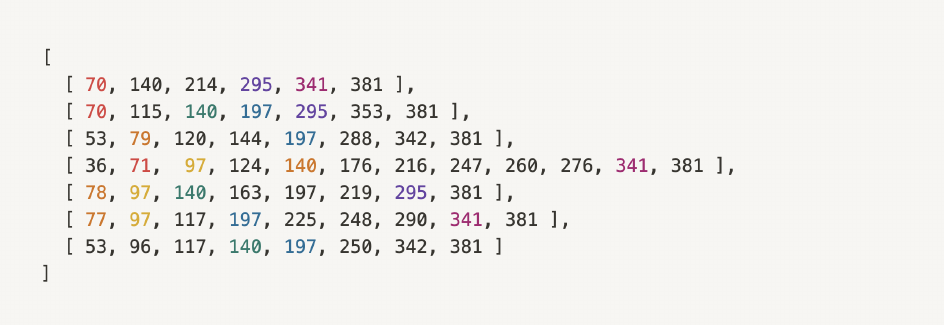
Figure 22. Topic segmentation points in ‘volunteer military